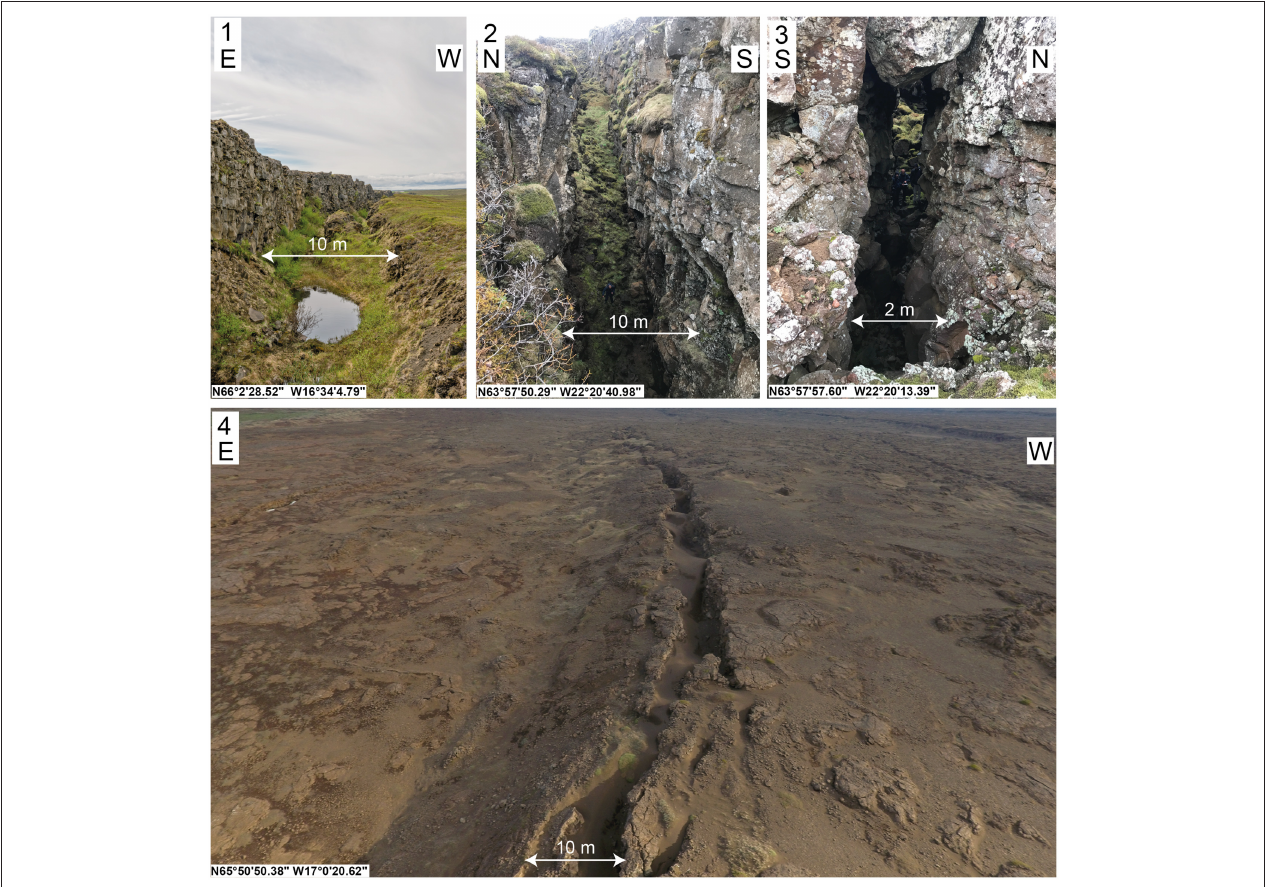
FIGURE 11 | Field sites on Iceland that may be compared to our analog models. Field impressions show exceptional outcrop conditions of the rift system, allowing for high-resolution mapping of structures close to the surface. Apertures of open fractures at the surface range from few cm to several tens of meters, as for instance observed at the famous world heritage site of Thingvellir. Correlating both sides of the open fracture is commonly possible at fractures of widths of 10 meters or less. Fractures are partly filled with rubble. Image 4 was taken with an unmanned aerial vehicle. Note the tilted block in foreground of image